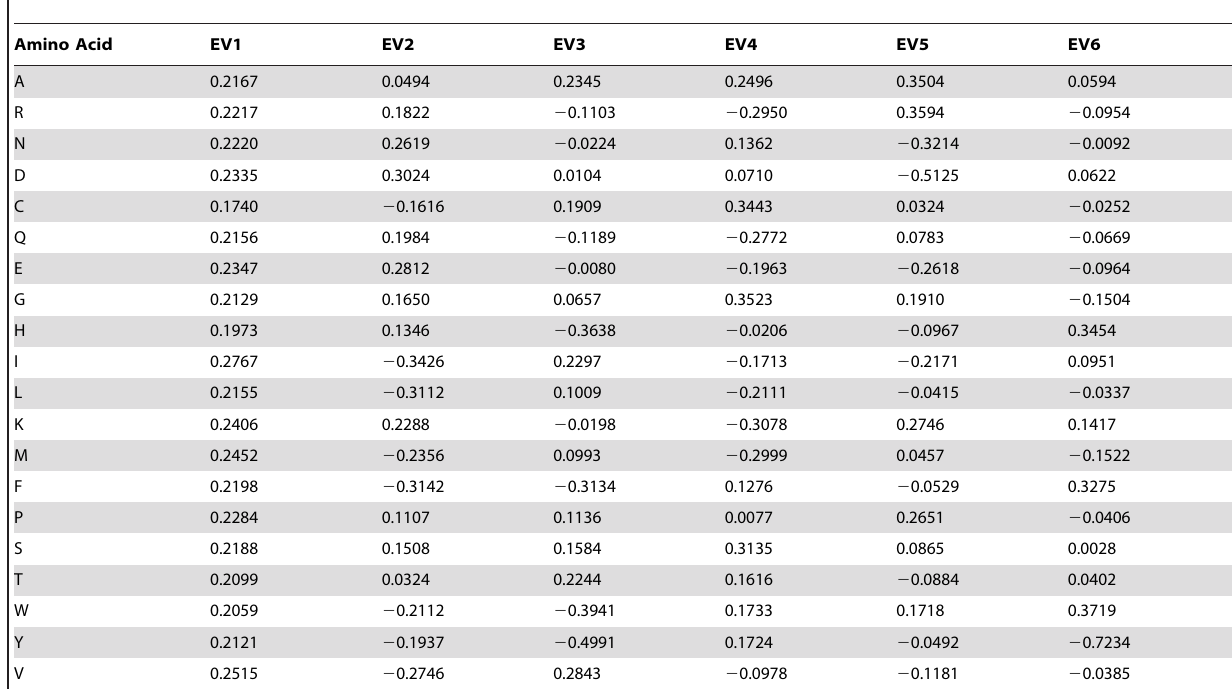
Table 1. Eigenvectors of BLOSUM100 matrix.